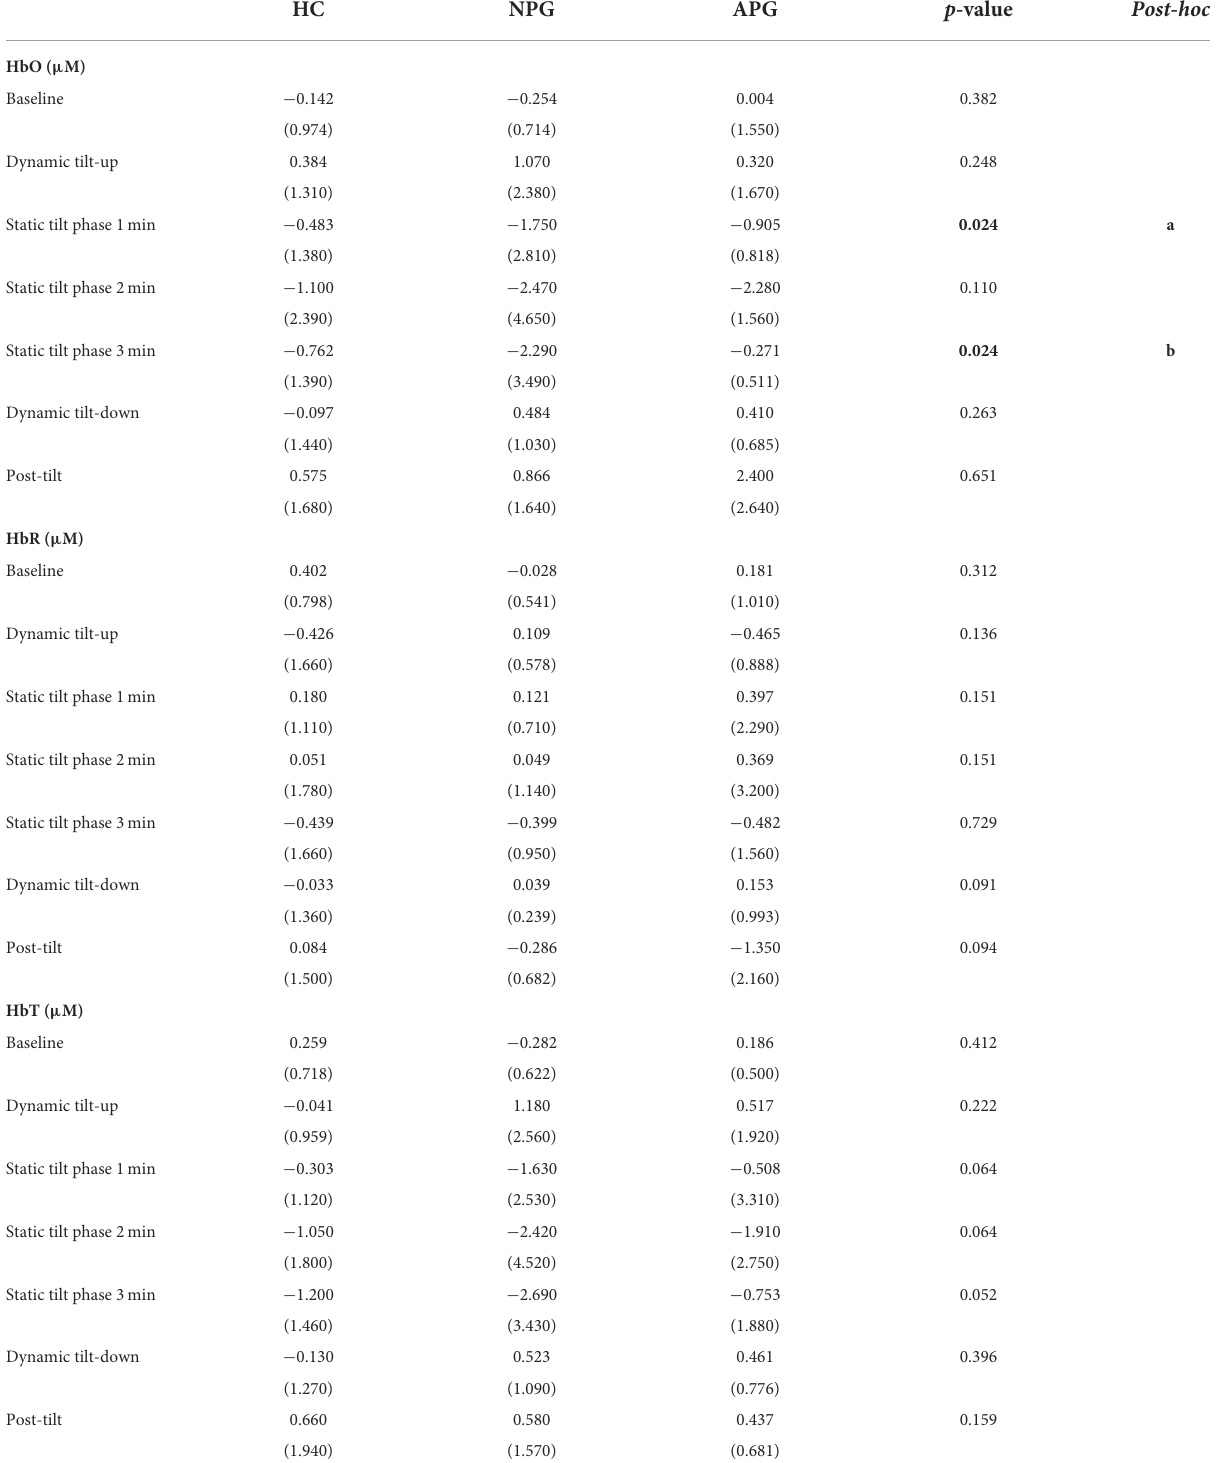
TABLE 3 Average HbO, HbR, and HbT values for each group during the five HUT